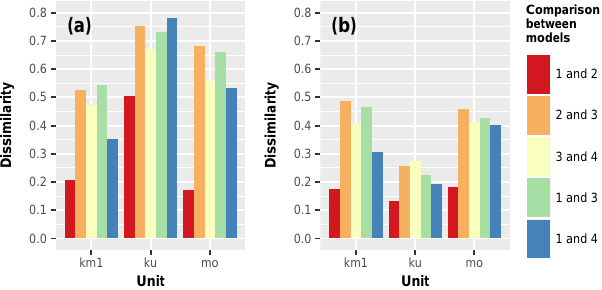
Figure 11. Dissimilarities between the different models expressed by (a) Jaccard distance and (b) city-block